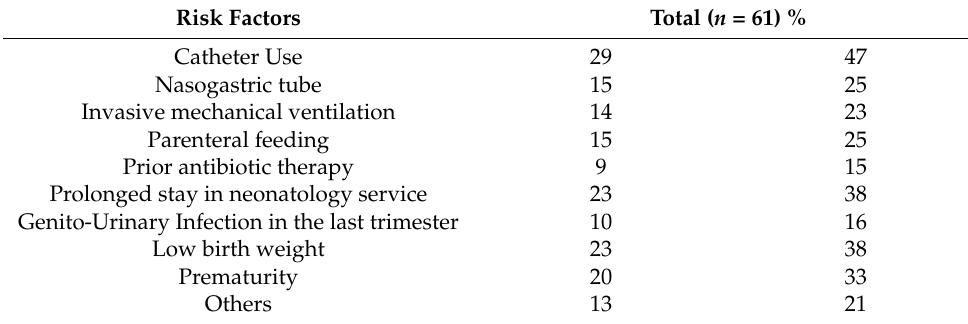
Low birth weight